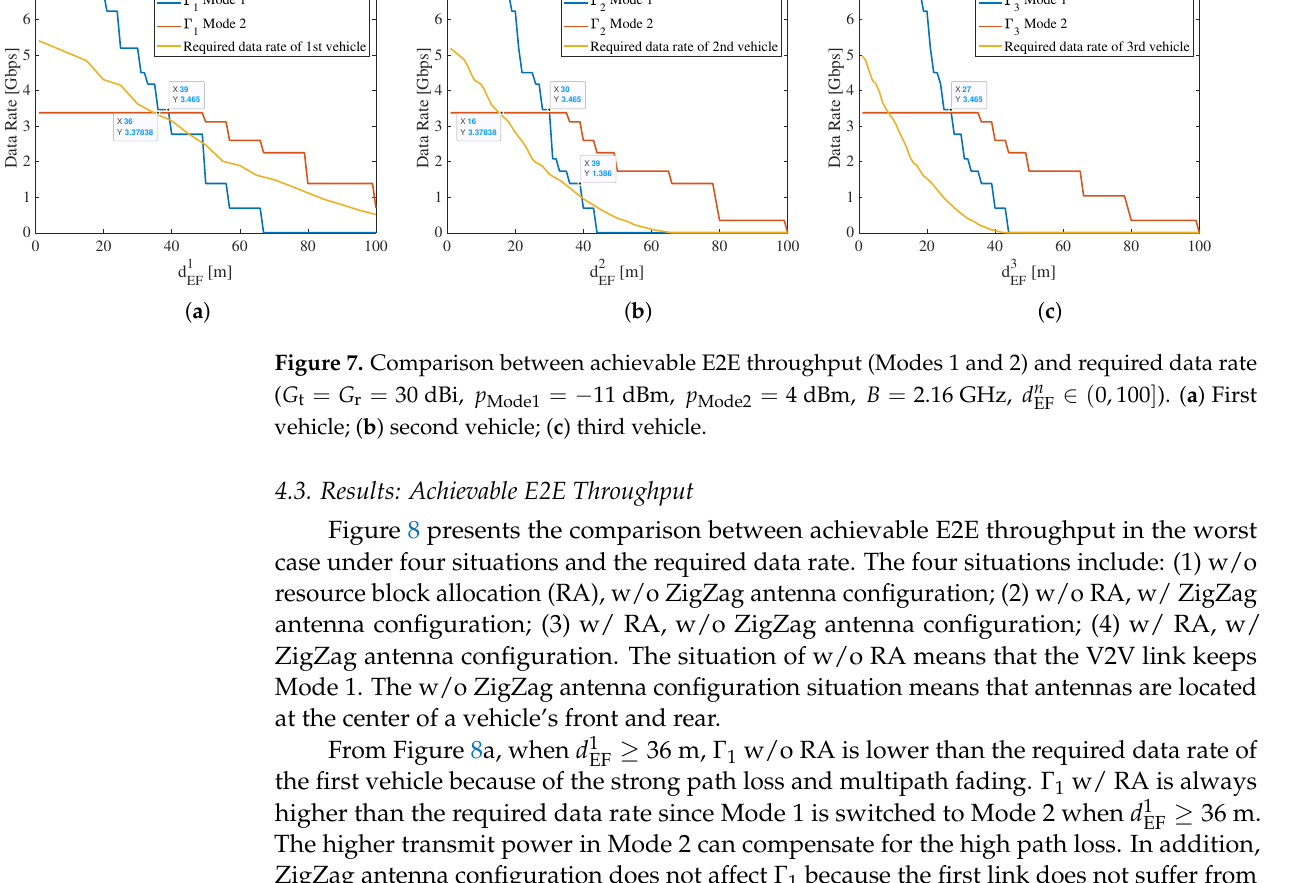
∈ ( 0,100 ] ). ( a ) First EF